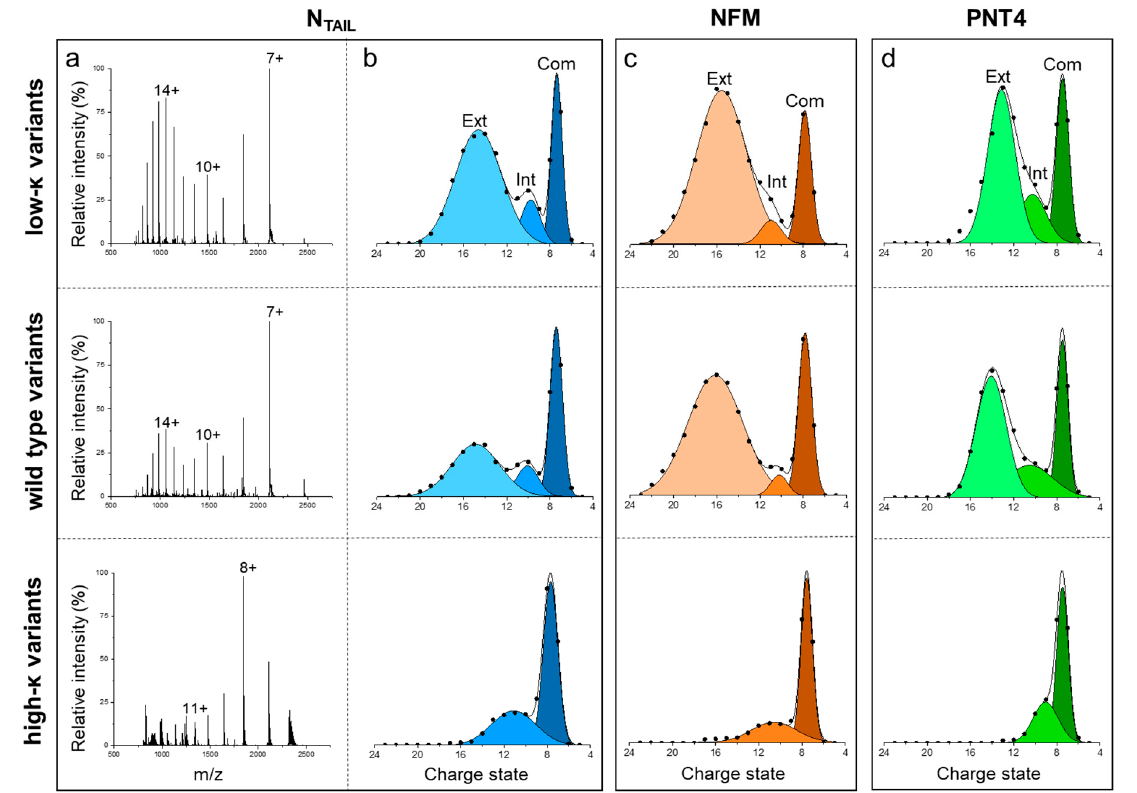
Figure 4. Native-MS analyses. ( a ) NanoESI-MS spectra of N TAIL variants acquired under non-denaturing conditions (50 mM ammonium acetate pH 7.0). The most intense signal of each peak-envelope is labeled by the corresponding charge state. ( b – d ) Multi-Gaussian deconvolution of the MS spectra obtained for N TAIL ( b ), NFM ( c ) and PNT4 ( d ), in the low- κ (upper row), wt (central row) and high- κ (bottom row) variants. Extended (Ext), intermediate (Int) and compact (Com) species are colored with different shades and labeled in the upper panels. MS spectra of NFM and PNT4 variants are reported in Figure S3.